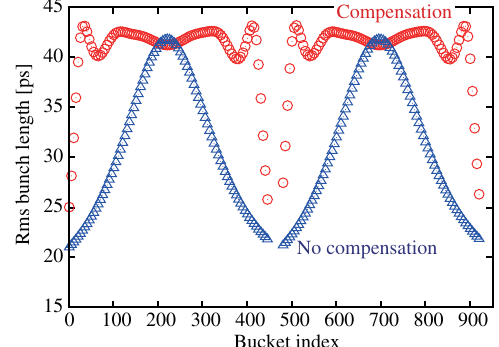
FIG. 12. Rms bunch lengths along the bunch trains with compensation (circles) using a separate cavity when compared to those without compensation (triangles). We assumed a stored current of 500 mA, two 60-ns bunch gaps, and a compensation half-bandwidth of 3